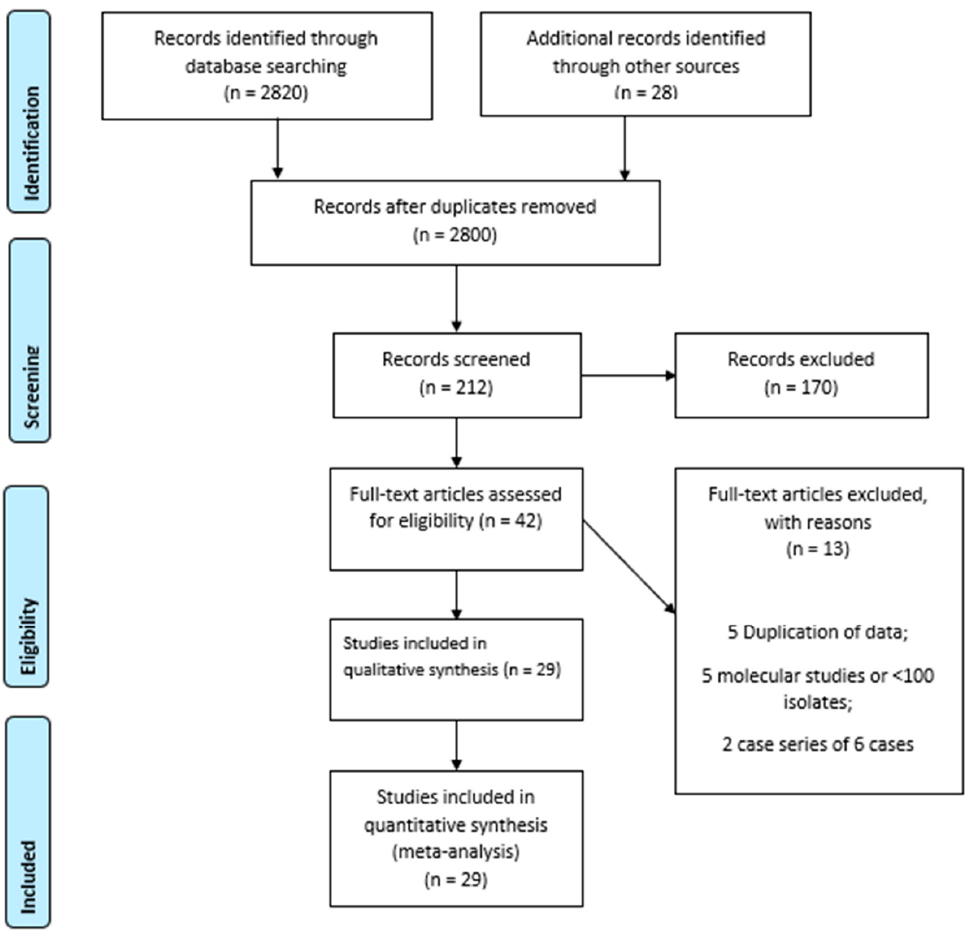
Figure 1. Preferred Reporting Items for Systematic Reviews and Meta-Analyses (PRISMA) 2009 Flow Diagram.